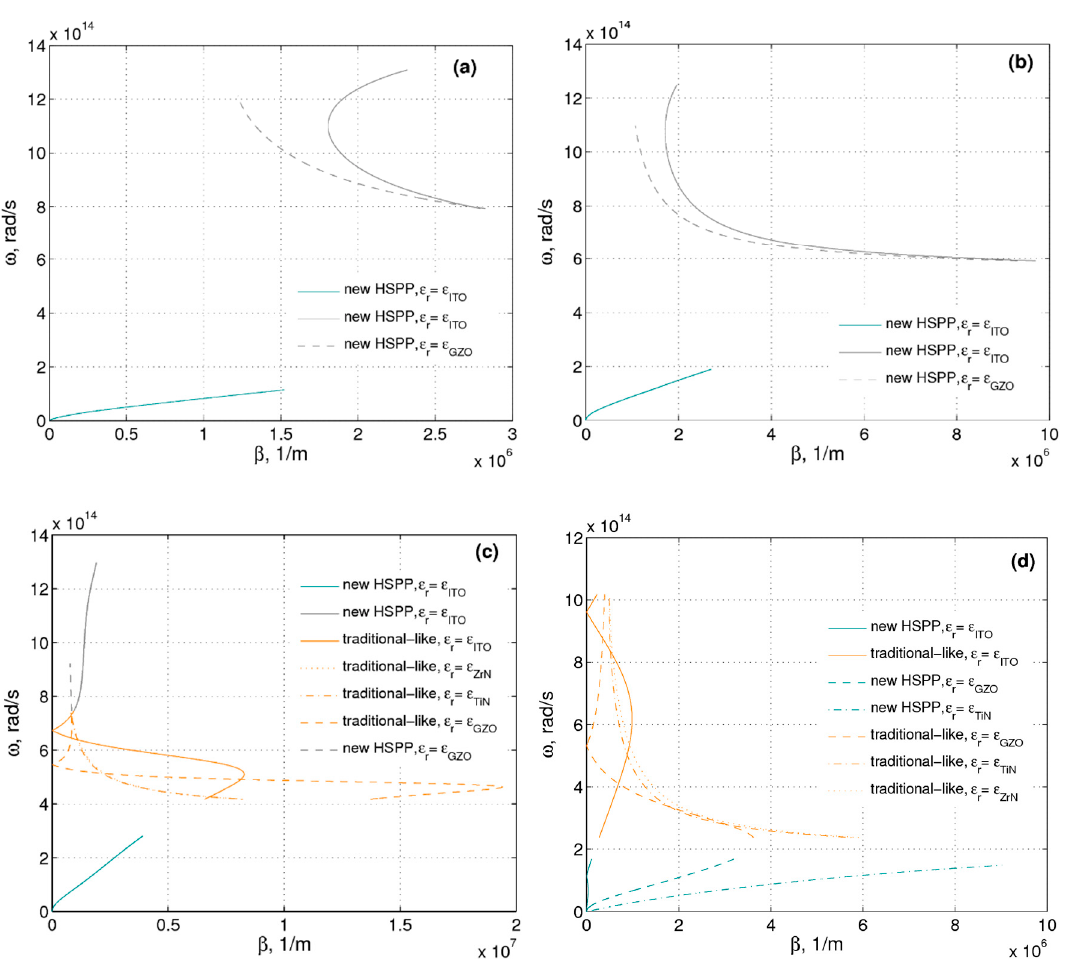
Figure 13. SPP dispersion for different TCO filling factors, i.e., f TCO = 0.3 in ( a ), f TCO = 0.5 in ( b ), f TCO = 0.7 in ( c ), and f TCO = 0.9 in ( d ), matching the MM/TCO